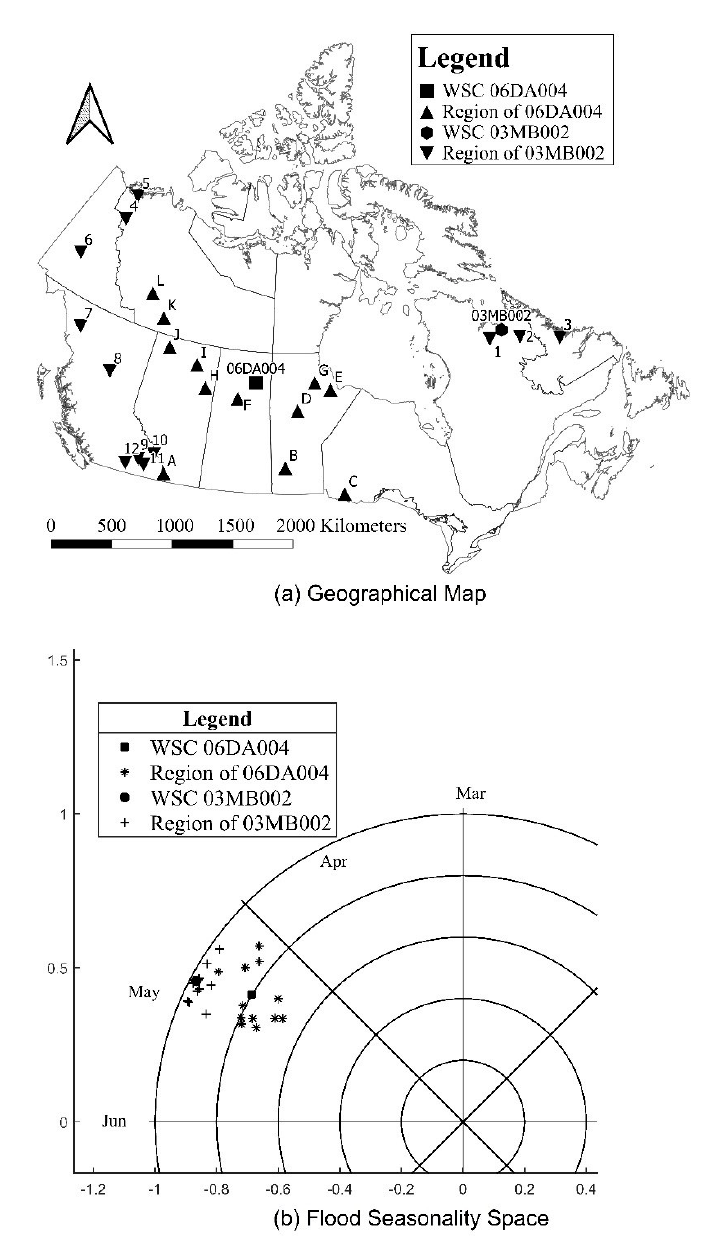
Figure 7. Region membership for study sites 03MB002 and 06DA004, presented by ( a ) geographical extent and in ( b ) flood seasonality space. Members for the 03MB002 (06DA004) region are labeled in ( a ) with numbers (alphabets) as they are referenced in Table 3.